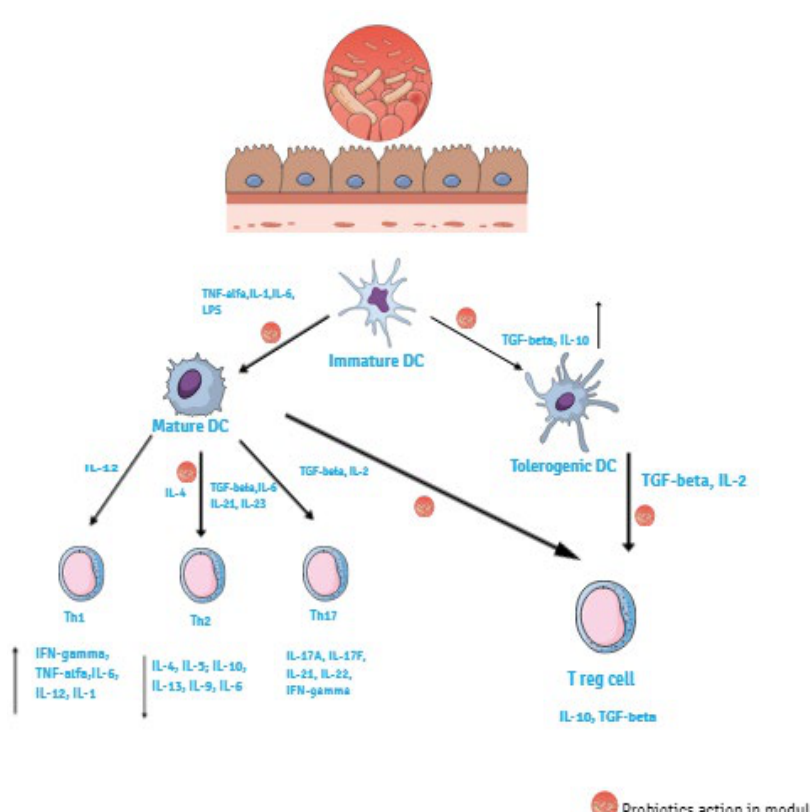
Figure 3. Immunomodulatory effects of probiotics. Probiotics regulate the differentiation of immature DCs into mature or tolerogenic DCs in the presence of pro-inflammatory stimuli (TNF- α , IL-1, IL-6, LPS) or anti-inflammatory stimuli (TGF- β , IL 10) respectively. Inflammatory Th1 cells are produced in presence of Il-1, IL-6, IL-12, IFN- γ , TNF- α , instead anti-inflammatory Th2 cells in presence of IL-4, IL-5, IL-9, IL-10, IL-13, IL-33. Probiotics exert their immunomodulatory effects on allergic diseases balancing Th1/Th2 immune response stimulating Th1 and decreasing Th2 response through different cytokines’ secretion and inducing beneficial Treg cells to promote immune toler- ance.